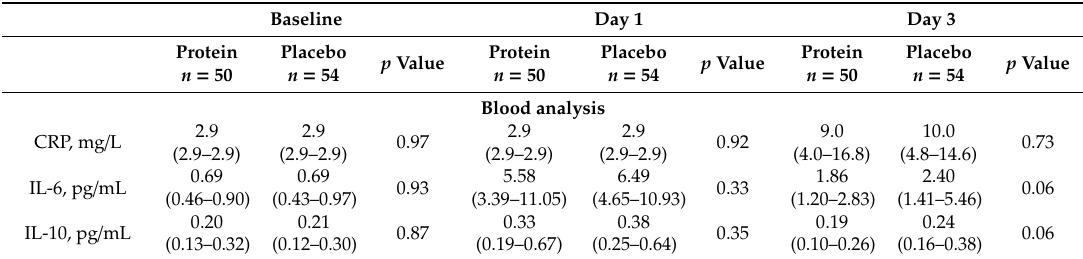
Table 5. Blood analysis during moderate-intensity